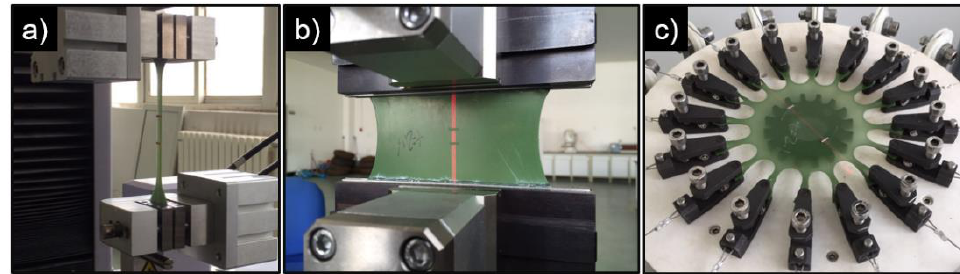
Figure 12. Homogeneous finite strain experimental equipment: ( a ) uniaxial tension, ( b ) planar ten- sion (pure shear) and ( c ) equibiaxial tension. tension (pure shear) and ( c ) equibiaxial